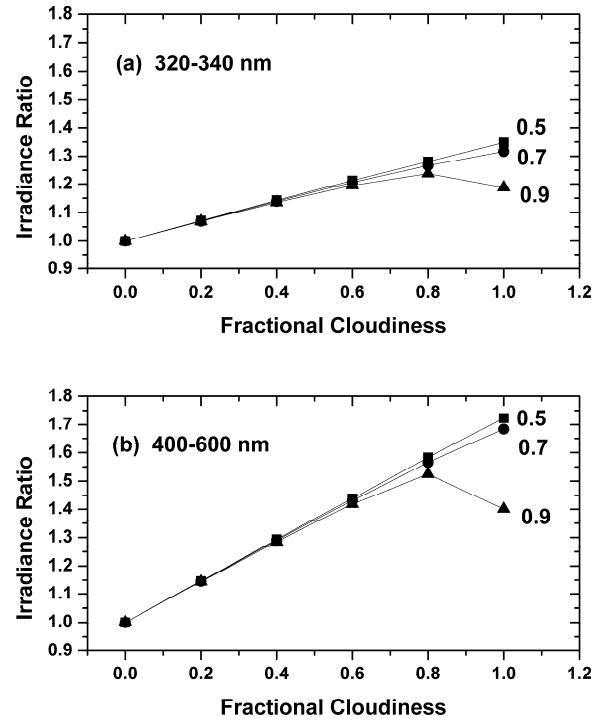
Fig. 9. Computed irradiance ratios as functions of fractional cloudi- ness for cloud albedos of A c =0.5, 0.7 and 0 . 9. The solar disk is not obscured by clouds, and the ground albedo is A G = 0 . 98. (a) 320– 340nm wavelength band. (b) 400–600nm wavelength